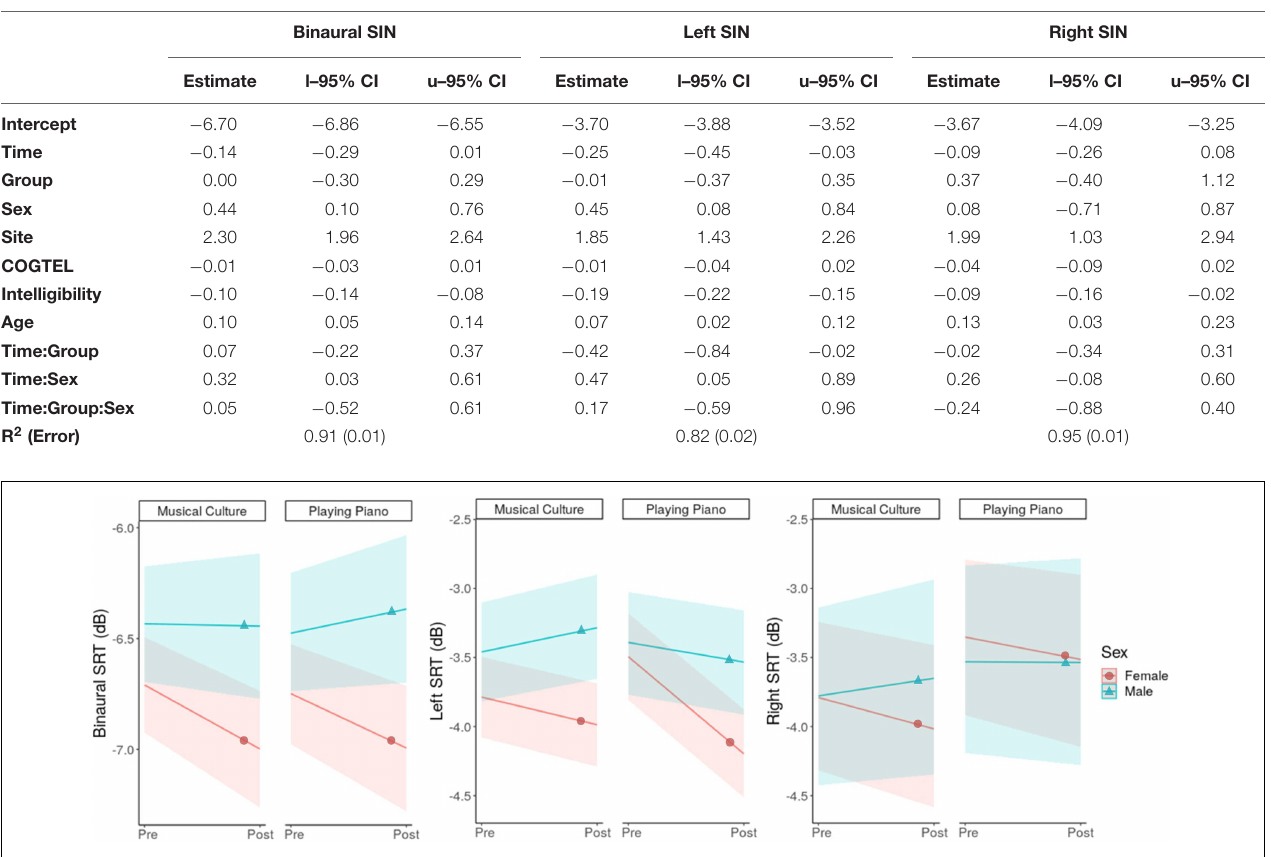
TABLE 3 | Population-level effects of the three-way-interaction models.